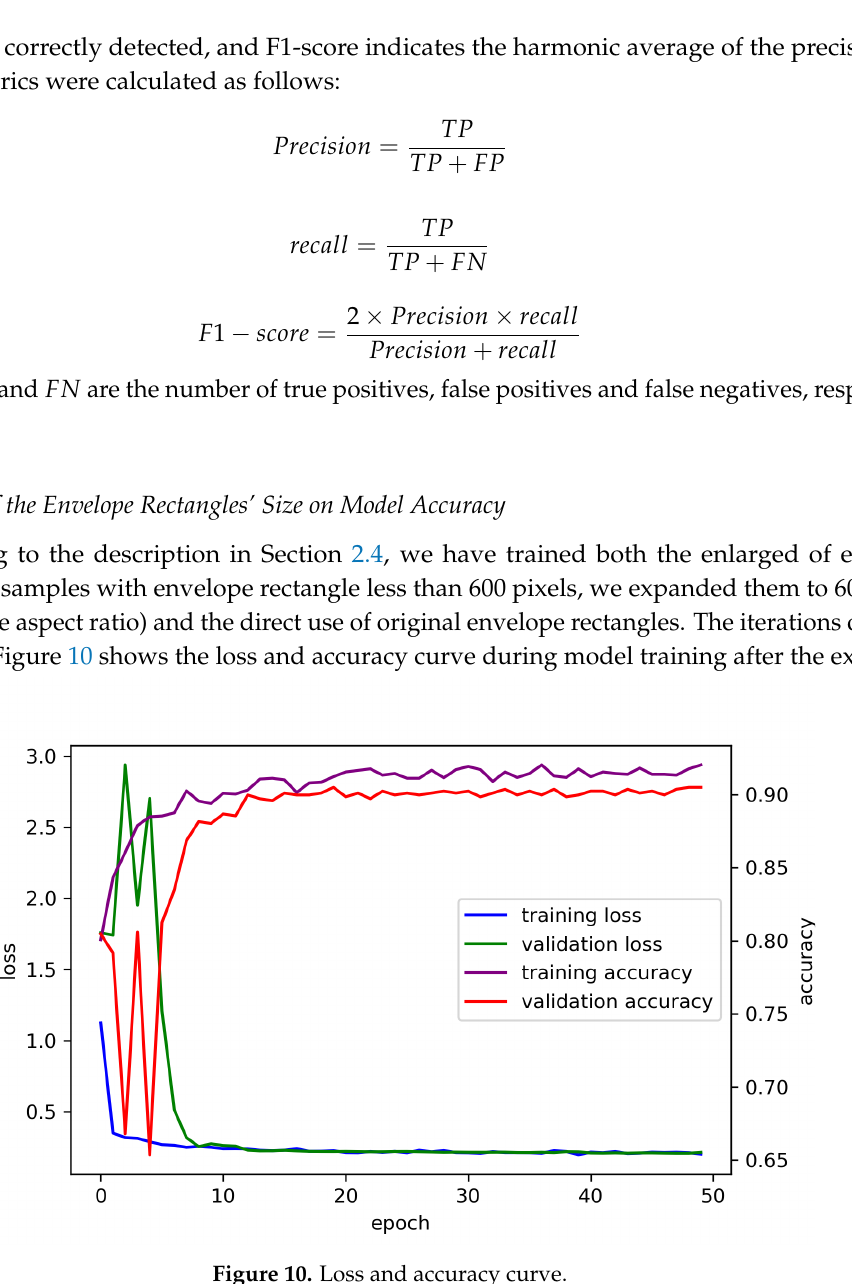
Figure 10. Loss and accuracy